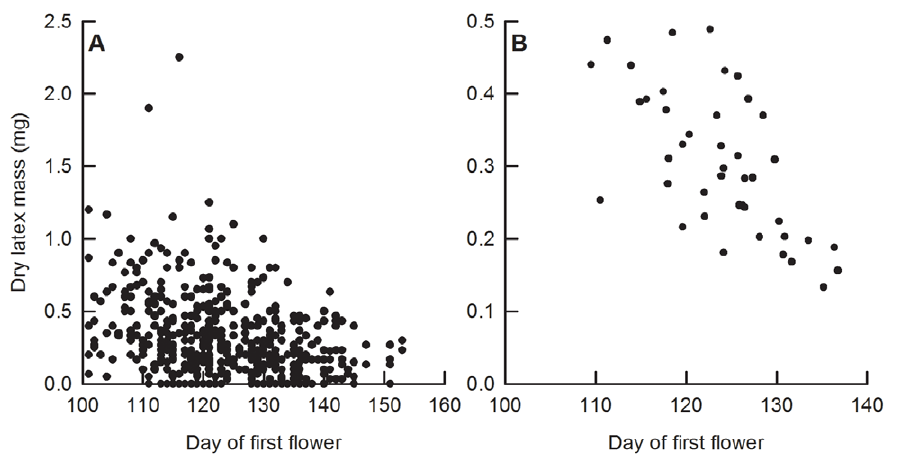
Figure 2. Relationship between flowering phenology and latex defence in greenhouse-grown Lobeliasiphilitica . ( A ) Phenotypic correlation between days to first flower and dry latex mass ( N =478). ( B ) Maternal family mean correlation between days to first flower and dry latex mass ( N =46). Note the scales differ between panels to allow for better visualization.